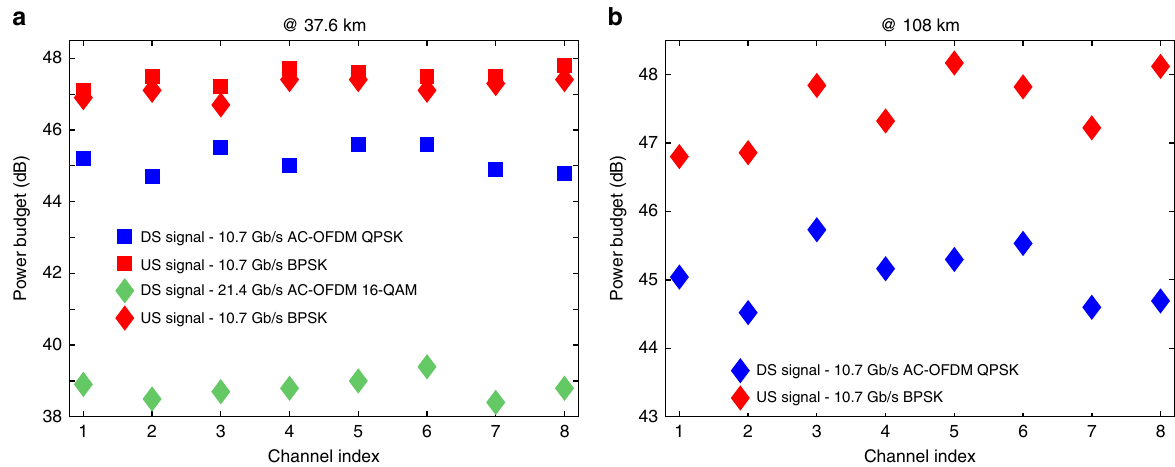
Fig. 6 Achieved power budgets for all signals in both transmission scenarios. a All DS channels operating at 10.7 and 21.4 Gb/s, and all US channels operating at 10.7 Gb/s over a transmission distance of 37.6 km of installed SSMF. b All 10.7 Gb/s DS and US channels over a transmission distance of 108 km of installed